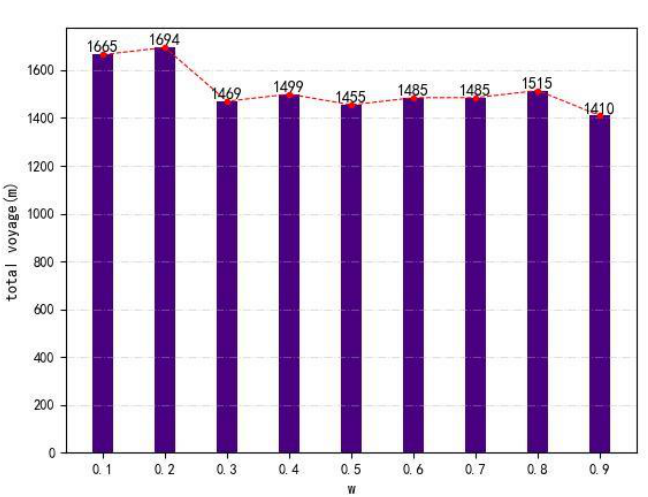
Figure 5. Total voyage with different w .